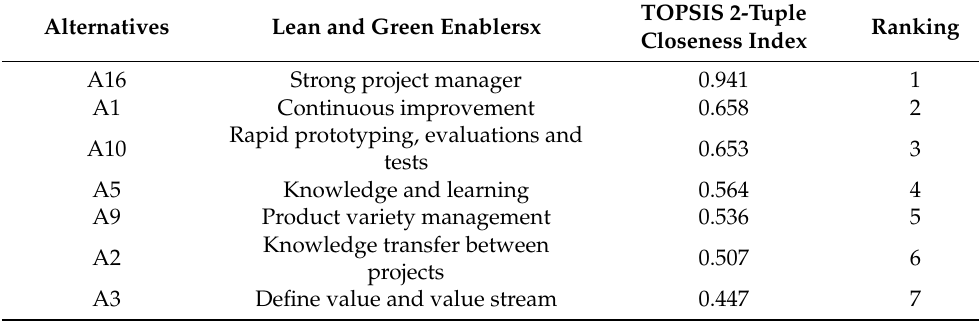
Table 8. TOPSIS 2-tuple closeness index from Japanese